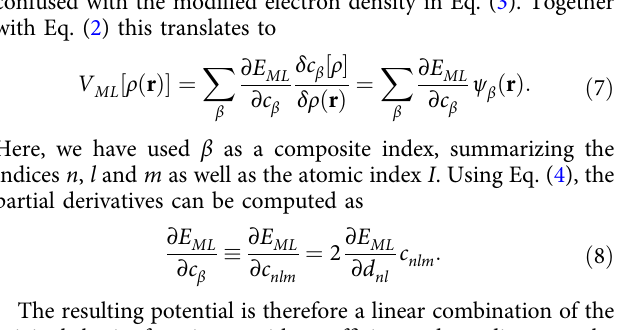
Fig. 1 Implementation of NeuralXC. Starting from the electron density in real space, obtained with a converged DFT calculation (using the baseline functional E base ), the projector maps this density to a set of descriptors c nlm . The symmetrizer creates rotationally invariant versions of these descriptors d nl , which, after preprocessing (not depicted here), are passed through a Behler – Parrinello type neural network architecture. By using the same network for descriptors of a given atomic species, we ensure permutation invariance. Once the energy E ML is obtained, its derivative can be backpropagated using the chain rule to obtain the machine-learned potential V ML . V ML is added back to the baseline potential V base = δ E base / δ n ( r ), to create the full V NXC ( r ), which can be used in subsequent self-consistent produce lower generalization errors (see “ Methods ” section for details).